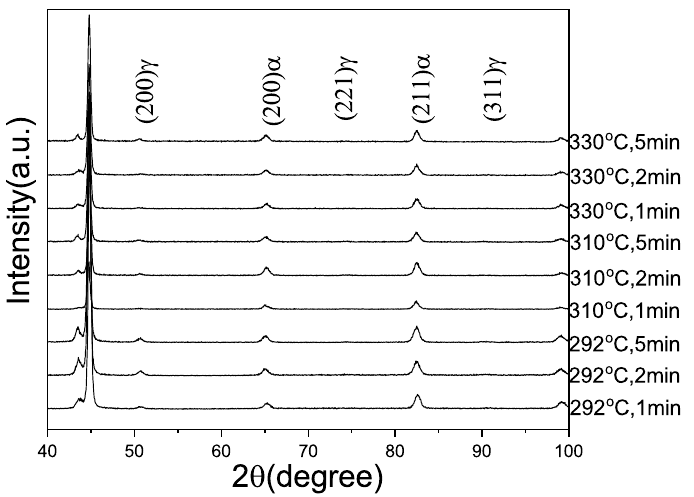
Figure 6. X-ray diffraction pattern at different quenching(the same as partitioning) temperature and partitioning